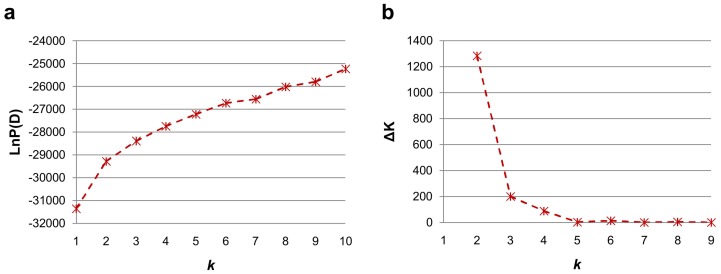
Estimated LnP(D) and ΔK over five repeats of STRUCTURE analysis.(a) LnP(D) for k from 1 to 10 for 356 accessions. LnP(D) value of each hypothetical k kept increasing with k value and did not show any peak. (b) ΔK for k from 2 to 9 for 356 accessions. The Δk value showed a much higher likelihood at k = 2 than at k = 3–10, suggesting that the total panel should be divided into two major subpopulations.